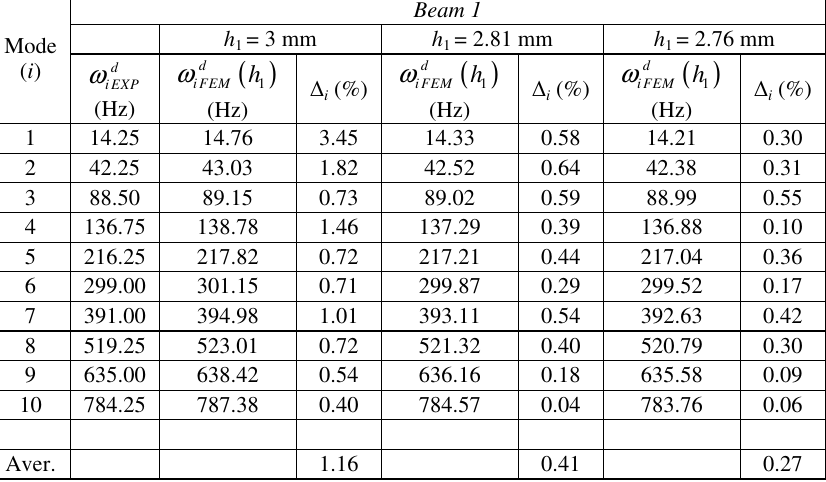
Aver. Table 3. Flexural frequencies and residuals for the Beam 2 calculated using identified damage extent